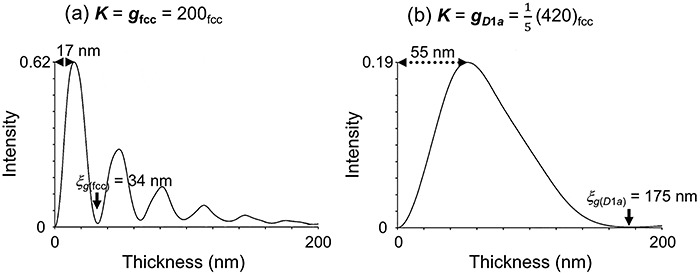
Calculated dynamical diffraction intensities in the Ni4Mo crystal as a function of crystal thickness [99]. (a) A fundamental lattice reflection, gfcc = 200fcc, under the exact Bragg condition, K = gfcc, showing the effective extinction distance of ξg(fcc) = 34 nm. (b) A superlattice reflection, gD1a = \documentclass[12pt]{minimal}
\usepackage{amsmath}
\usepackage{wasysym}
\usepackage{amsfonts}
\usepackage{amssymb}
\usepackage{amsbsy}
\usepackage{upgreek}
\usepackage{mathrsfs}
\setlength{\oddsidemargin}{-69pt}
\begin{document}
}{}$\frac{1}{5}$\end{document}(420)fcc, for K = gD1a showing ξg(D1a) = 175 nm.